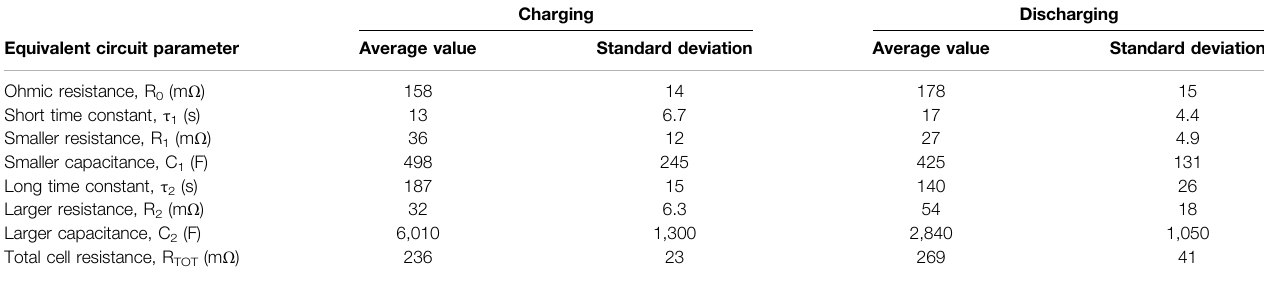
TABLE 1 | Time constants of interruption tests and equivalent circuit component values measured in phase 2 with a gap of 1.25 mm on each side of the membrane. Charging Discharging Equivalent circuit parameter Average value Standard deviation Average value Standard deviation Ohmic resistance, R 0 (m Ω )